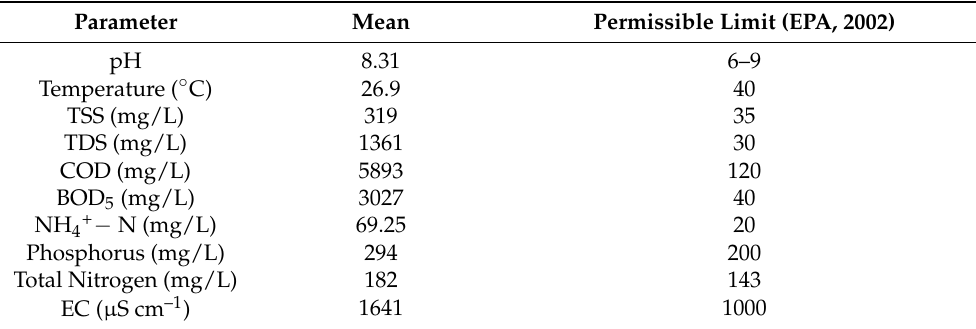
Table 2. GSBE characteristics and standard discharge